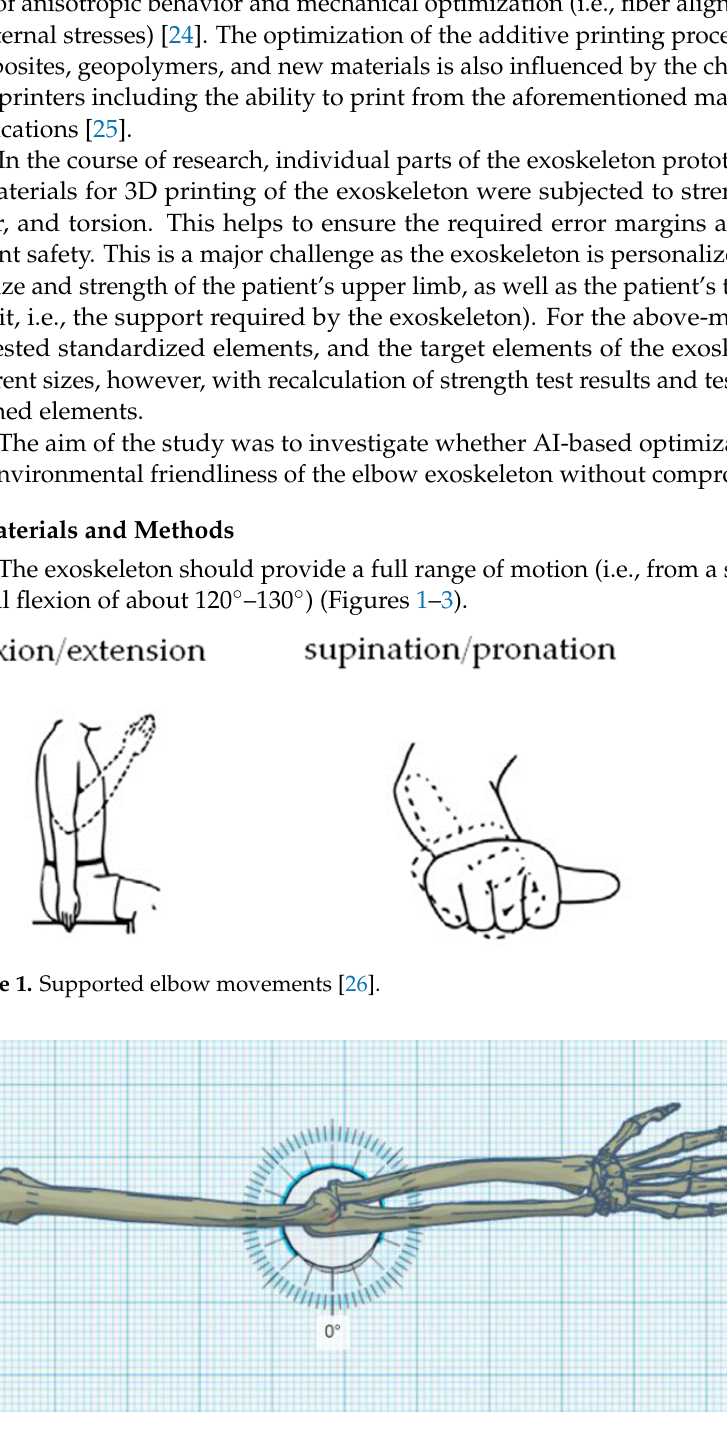
Figure 2. Straighten elbow with marked 120 ◦ angle of rotation.